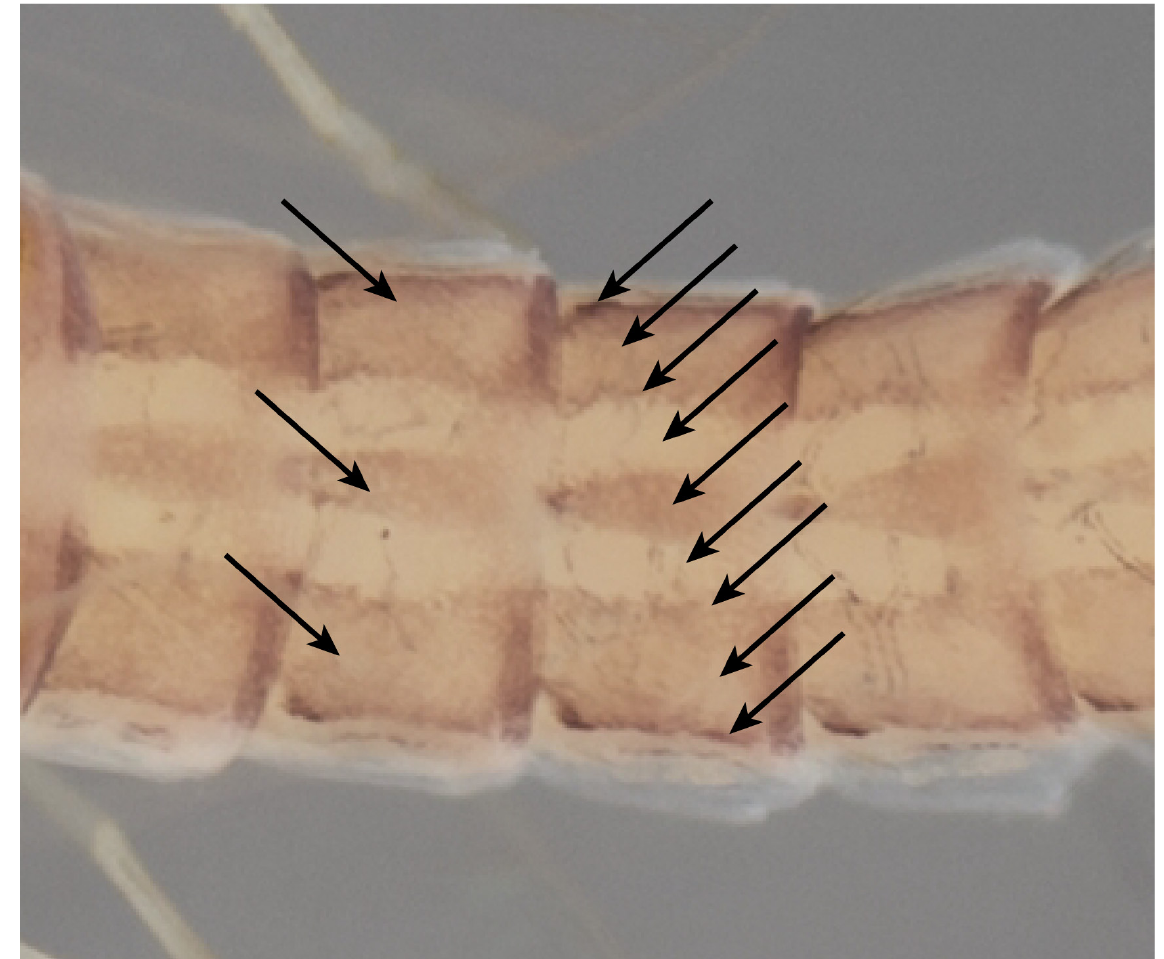
Fig. 8. Cloeon perkinsi , ♀ abdominal terga II–V. Arrows presenting two different methods of counting the lines. Left: counting only the dark stripes (three stripes in total). Right: counting dark and bright stripes, including darker borders of stripes (seven dark lines in